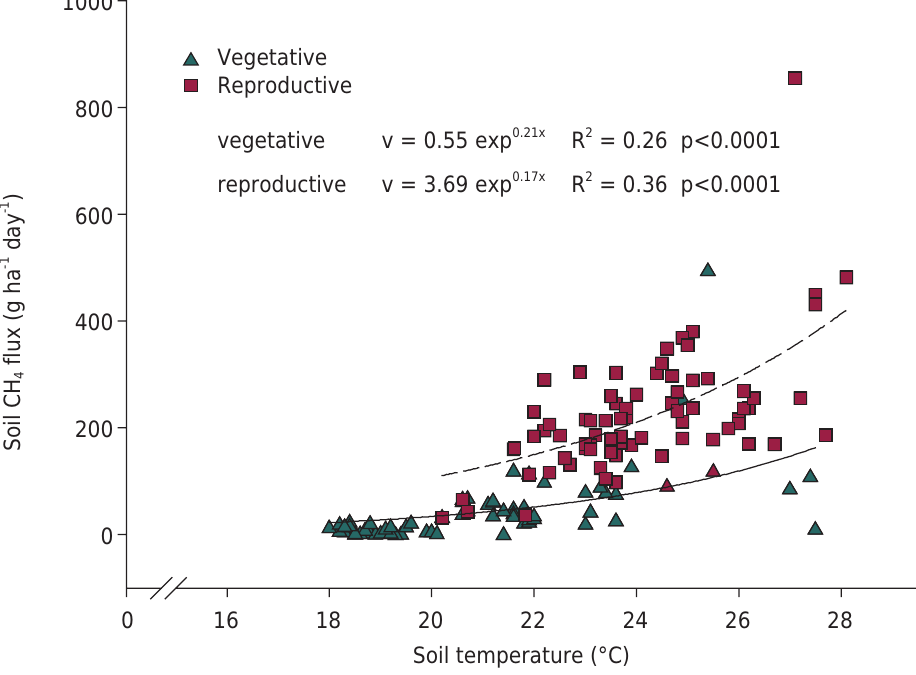
Figure 3. Relationship between soil temperature and CH 4 fluxes in the vegetative and reproductive stages of rice in southern